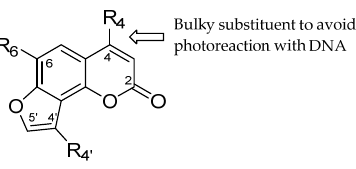
Figure 2. General structure of TMA analogs. See Tables 1–3 for the R specification. Table 1. R substituents for the A series of TMA analogs. Compounds